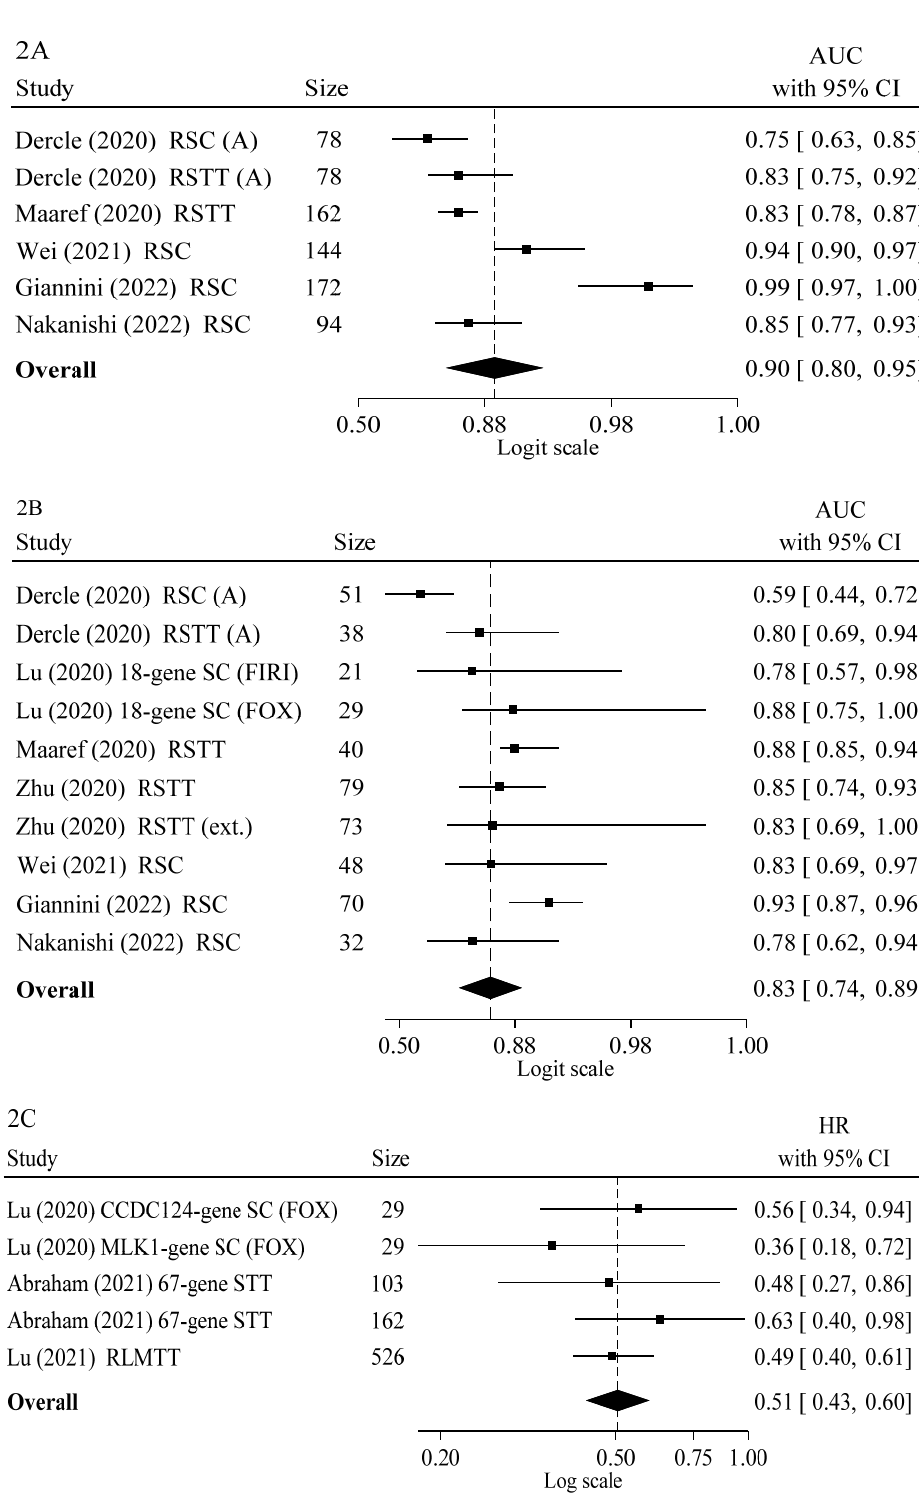
Figure 2. Meta-analysis of 21 artificial intelligence predictive models of response to therapy for metastatic colorectal cancer (mCRC) patients. The efficacy of learning algorithms in discriminating responders mCRC patients/treated metastatic lesions vs. non-responders mCRC patients/untreated metastatic lesions was analyzed by estimating the area under the receiver operating characteristic (ROC) curve (AUC) and 95% Confidence Intervals (C.I.) in training ( A ) and validation sets ( A , B ). ( C ) shows efficacy of the Hazard Ratios (HRs) and 95% C.I. from proportional hazards models (Cox regression) to predict improved survival.